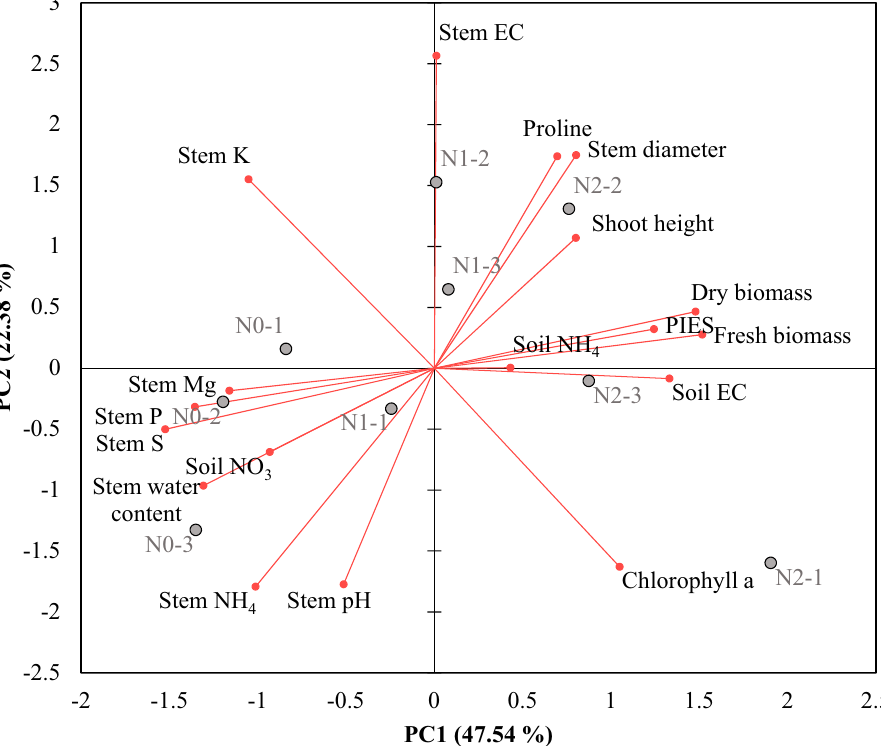
Figure 4. Biplot of PC1 and PC2 for growth parameters of pepper plants grown in different amount of urea applied soils (low fertilizer: N0, control: N1, high fertilizer: N2, numbers after dash indicate